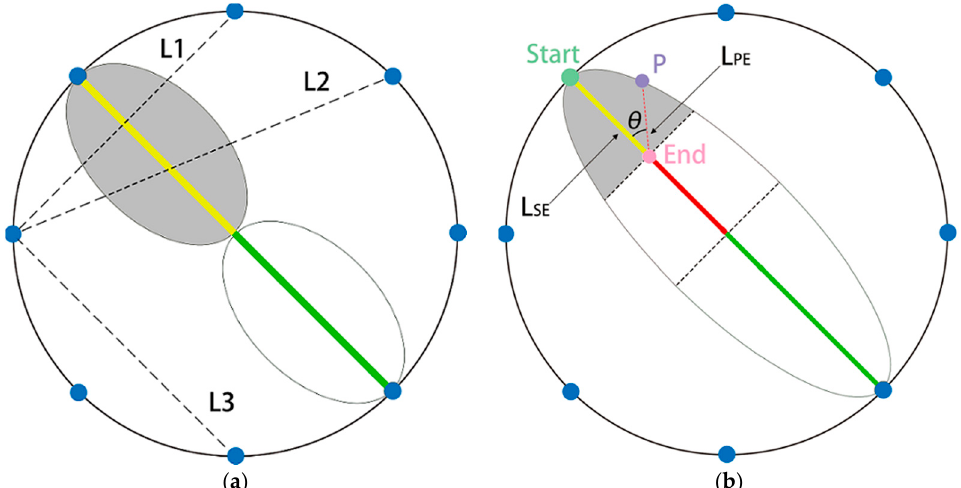
Figure 3. Illustration of the key steps in RSEN and SISE: ( a ) Strategy for estimating the value of the segmented ray; ( b ) strategy for selection of affected regions according to the segmented rays.